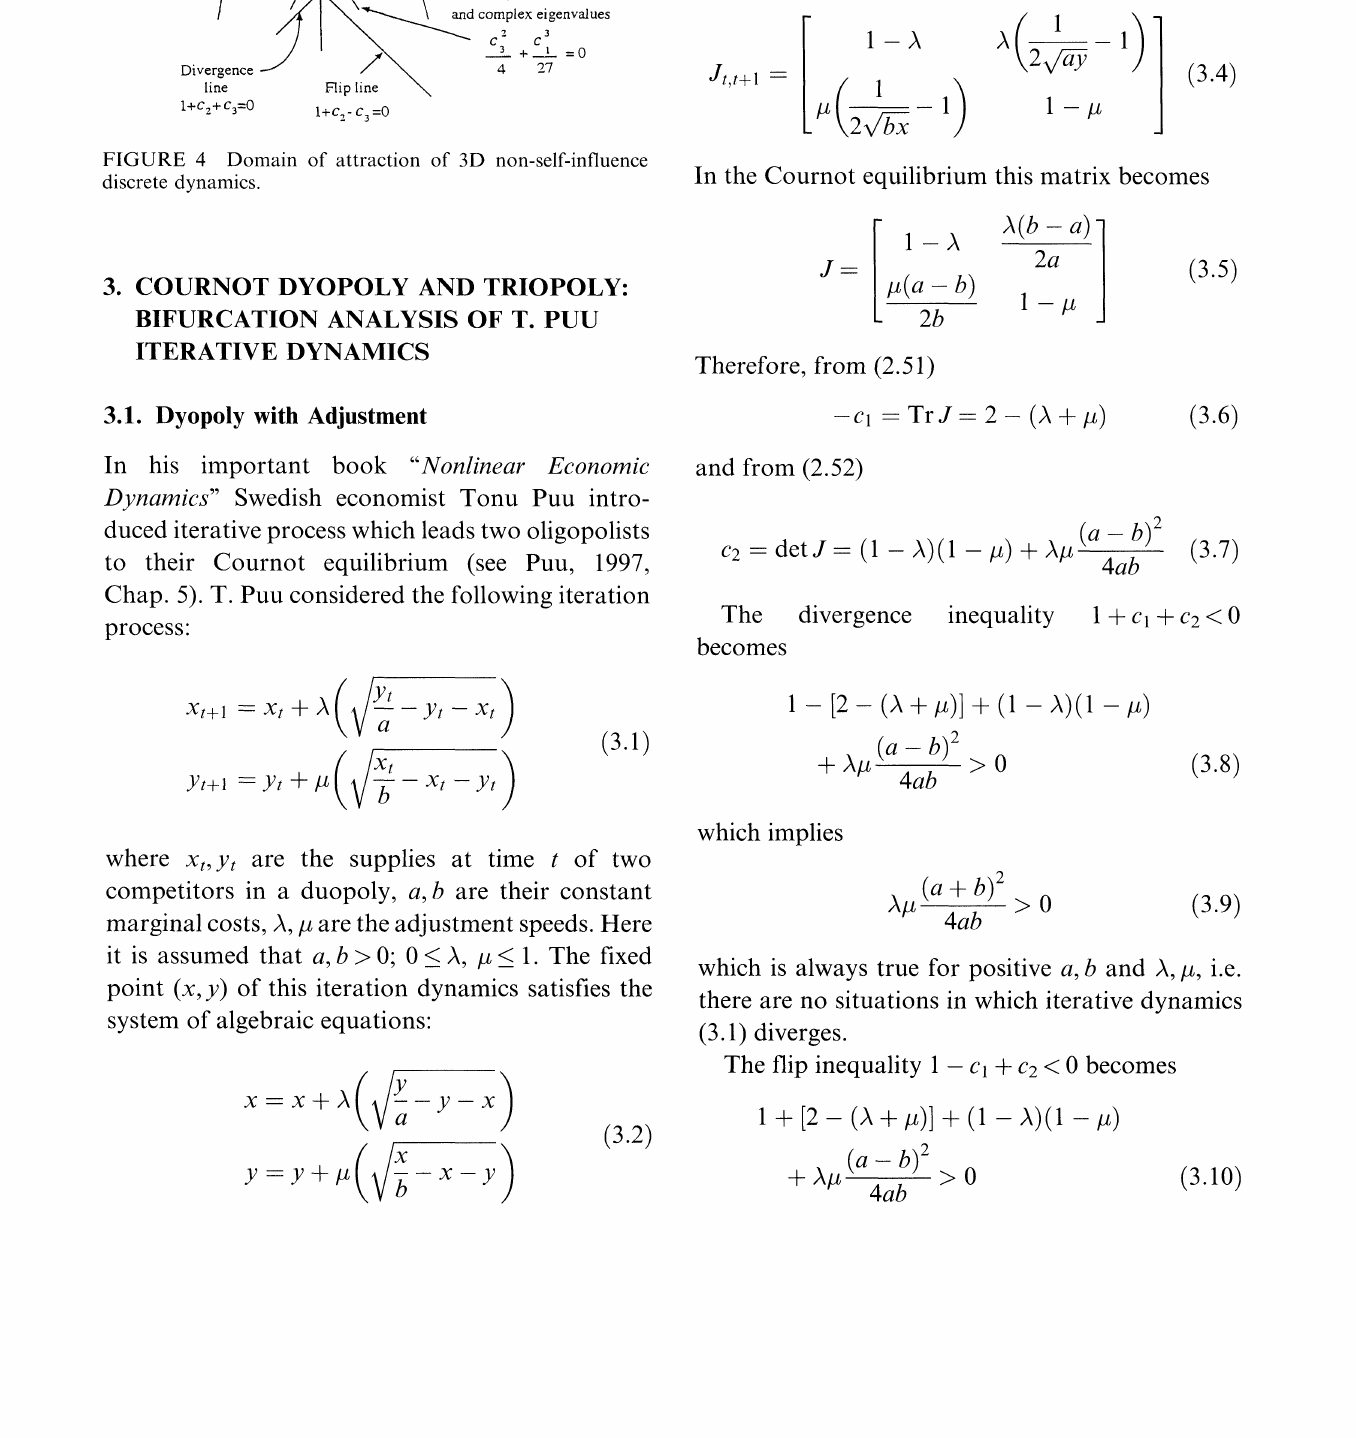
FIGURE 4 Domain of attraction of 3D non-self-influence discrete